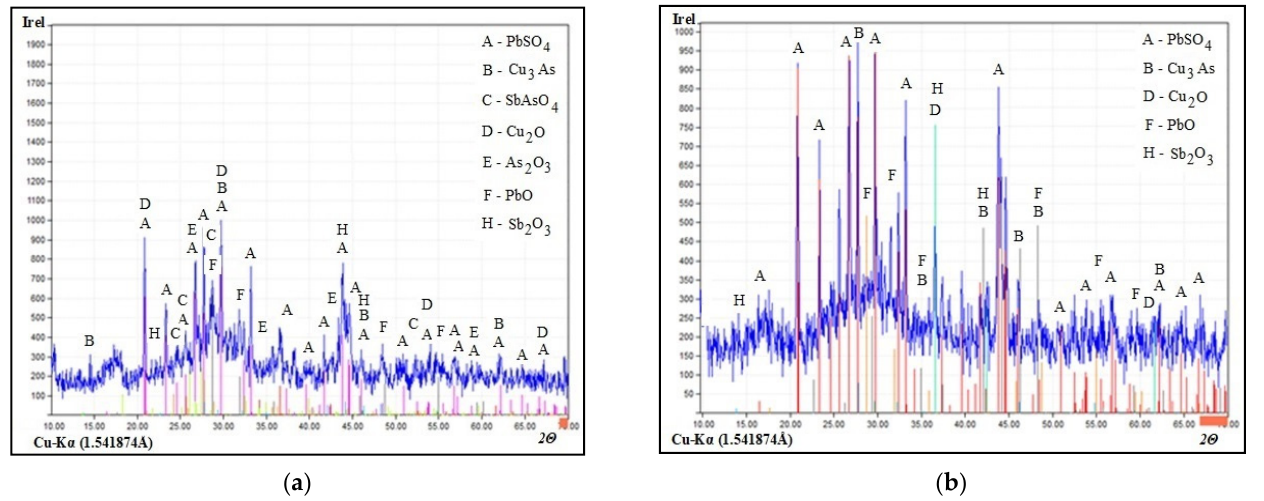
Figure 4. X-ray diffraction patterns of homogenized slime after electrorefining of anode with the sample code An-1: ( a ) working electrolyte temperature of T1 = 63 ± 2 °C and ( b ) working electrolyte temperature of T2 = 73 ± 2 °C.